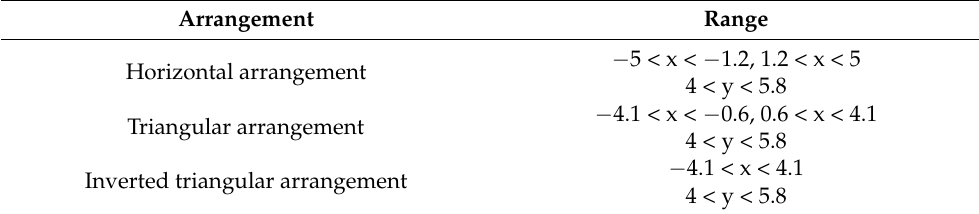
Table 6. UAV flight area.